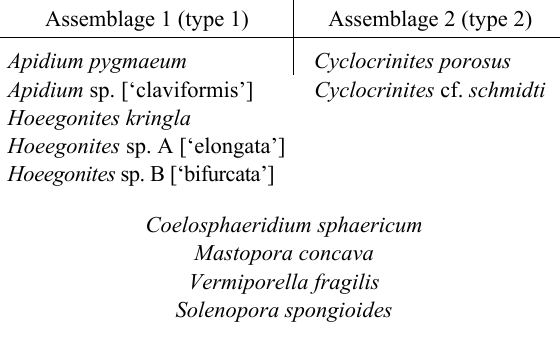
Table 1. Distribution of algae over the two distinct